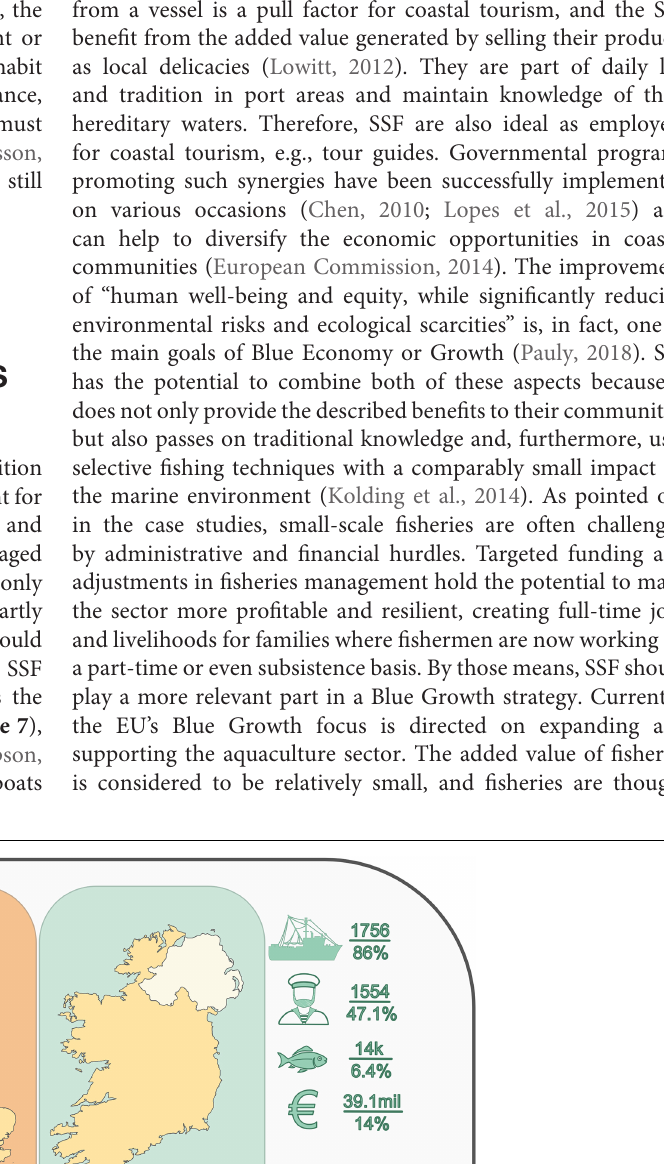
Frontiers in Marine Science |